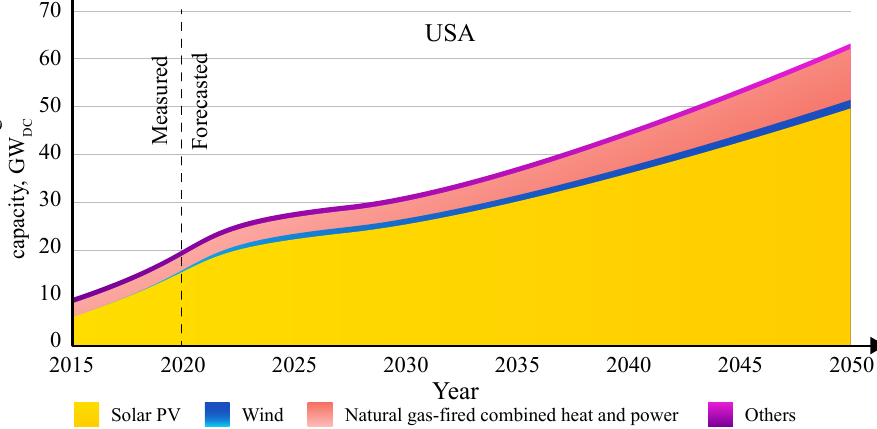
Figure 24. Growth projections for distributed generation and the prominent role of solar energy in the DG market. Source: EIA Annual energy outlook